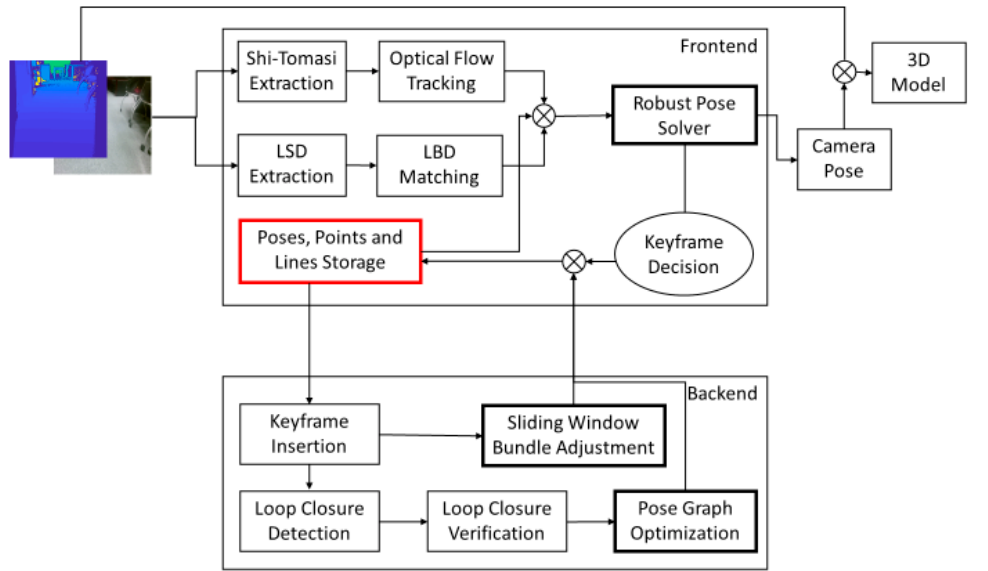
Figure 1. System overview. The input of the proposed system is the calibrated RGB and depth frames, and the output is the camera pose and 3D model. The proposed system has two parts: frontend and backend. We extract and match point and line features, and estimate the camera pose in the frontend. We apply sliding-window bundle adjustment to update camera poses, points and lines and apply loop closure correction to refine camera poses in the backend.